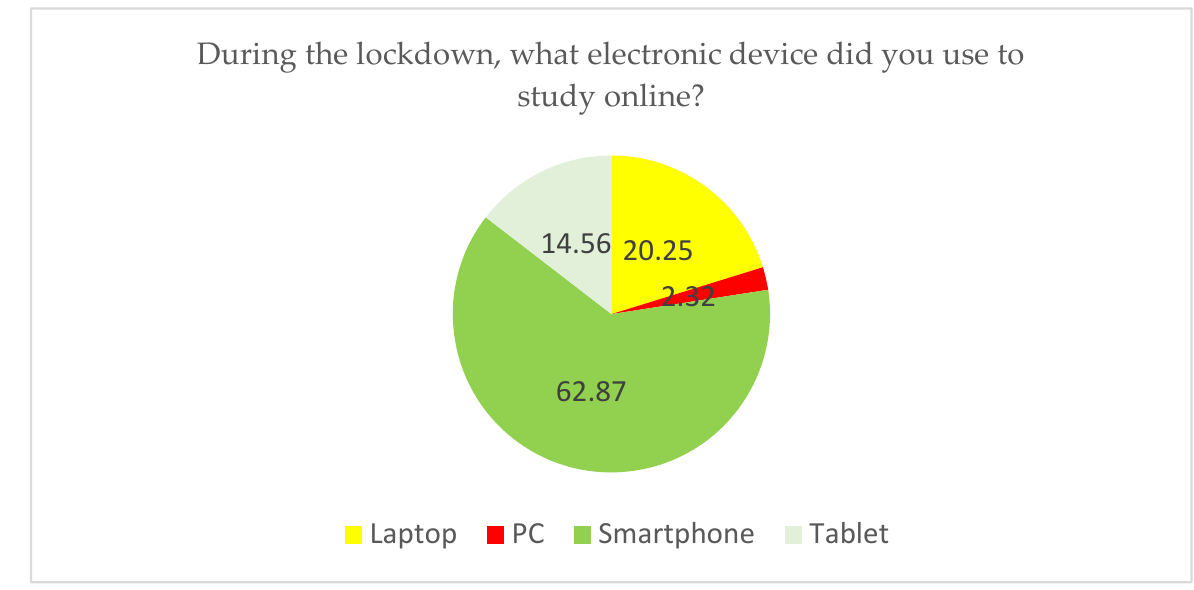
Figure 2. The device used by participants to access online.